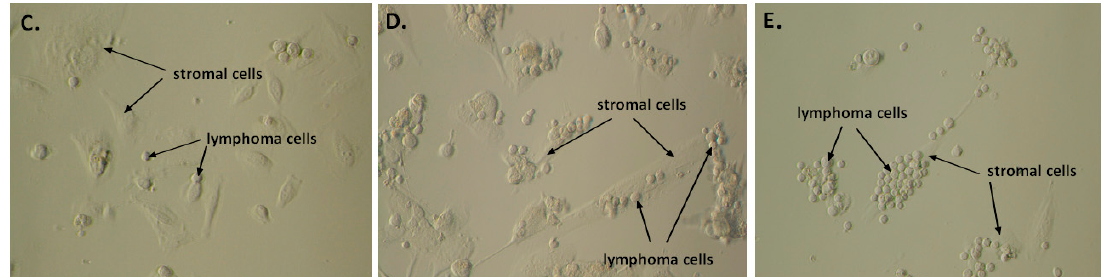
Figure 6. Adhesion of Ri-1 and U2904 cells to mesenchymal stromal cells ( A ) and Matrigel ( B ) in normoxia and physioxia. Each column represents the average of three independent replicates. Error bars represent ± S.D. The symbols (*) and (**) indicate a significant differences in lymphoma cells adhesion in normoxia and physioxia considering a p -value < 0.05 and <0.01, respectively. The symbols ( # ), ( ## ) and ( ### ) indicate a significant differences between Ri-1 and U2904 cells adhesion in normoxia considering a p -value < 0.05, <0.01 and <0.001, respectively; Student’s t -test. Ri-1 cells adhesion to stromal cells after 10 min ( C ) and 30 min ( D ) of co-incubation. Toledo cells line adhesion to stromal cells after 60 min of co-incubation ( E ). Magnification ×200.